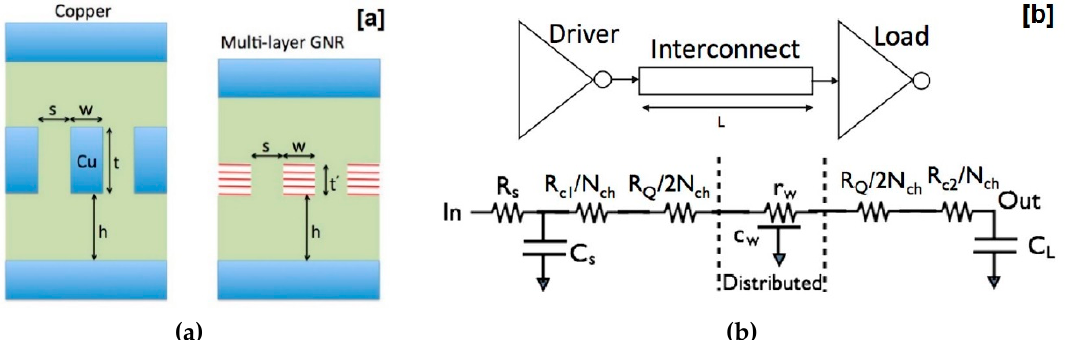
Figure 17. ( a ) Cross section of Cu and MLGNR. For ITRS 9.5 technology node, w = 9.5 nm, s = 9.5 nm,